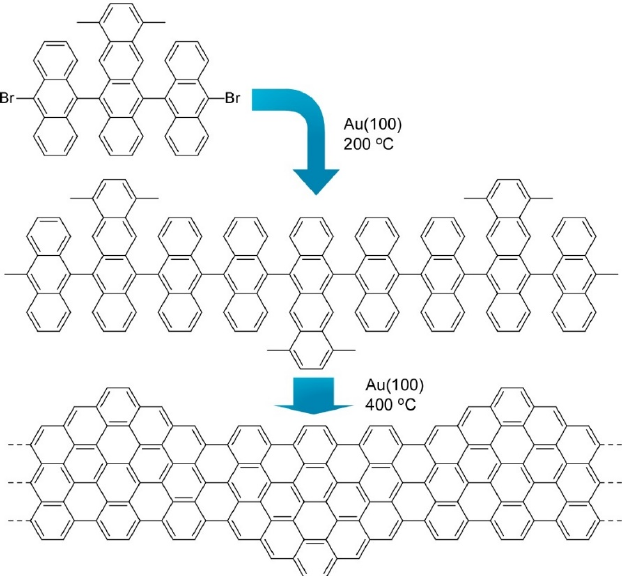
Figure 7. Fusion of molecules with a dimethyltetracene core and two bromoanthryl units into structure defined graphene nanoribbons. Kawai and co-workers demonstrated on-surface synthesis for regioisomeric gra- phene nanoribbons through fusion of two kinds of precursor molecules (Figure 8) [78]. Three different regioisomeric junctions were synthesized from 10,10’-dibromo-9,9’-bian- thryl and 1,3,6,8-tetrabromopyrene on a Au (111) surface. When a sufficient amount of 10,10’-dibromo-9,9’-bianthryl relative to 1,3,6,8-tetrabromopyrene was supplied, 10,10’- dibromo-9,9’-bianthryl molecules were reacted at bromo-substituted sites in 1,3,6,8-tetra- bromopyrene through an Ullmann-type reaction. Depending on the geometric relation between two reaction sites, subsequent cyclodehydrogenation upon high-temperature an- nealing resulted in graphene nanoribbon junctions with different connecting angles. Fur- ther analyses by scanning tunnelling spectroscopy with a CO-terminated tip with the aid of density functional theory (DFT) calculations revealed chemical structures and the elec- tronic properties of these structure-defined graphene nanoribbons. The demonstrated nanoarchitectonics strategy would be applied to the other units to produce various carbon nanostructures. Nakamura et al. reported the synthesis of -extended diaza [8] circulene through a combination of in-solution and on-surface syntheses (Figure 9) [79] . The final form of -extended diaza[8]circulene possessing six hexagons and two pentagons cannot be obtained only with solution-based reaction processes. The final cyclodehydrogenation step has to be done on a Au(111) surface.